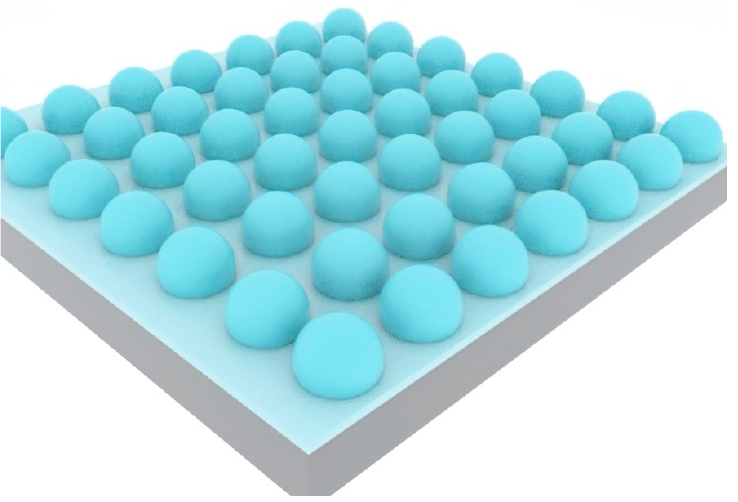
Figure 6. Wafer blowing of spherical alkali vapor cells.